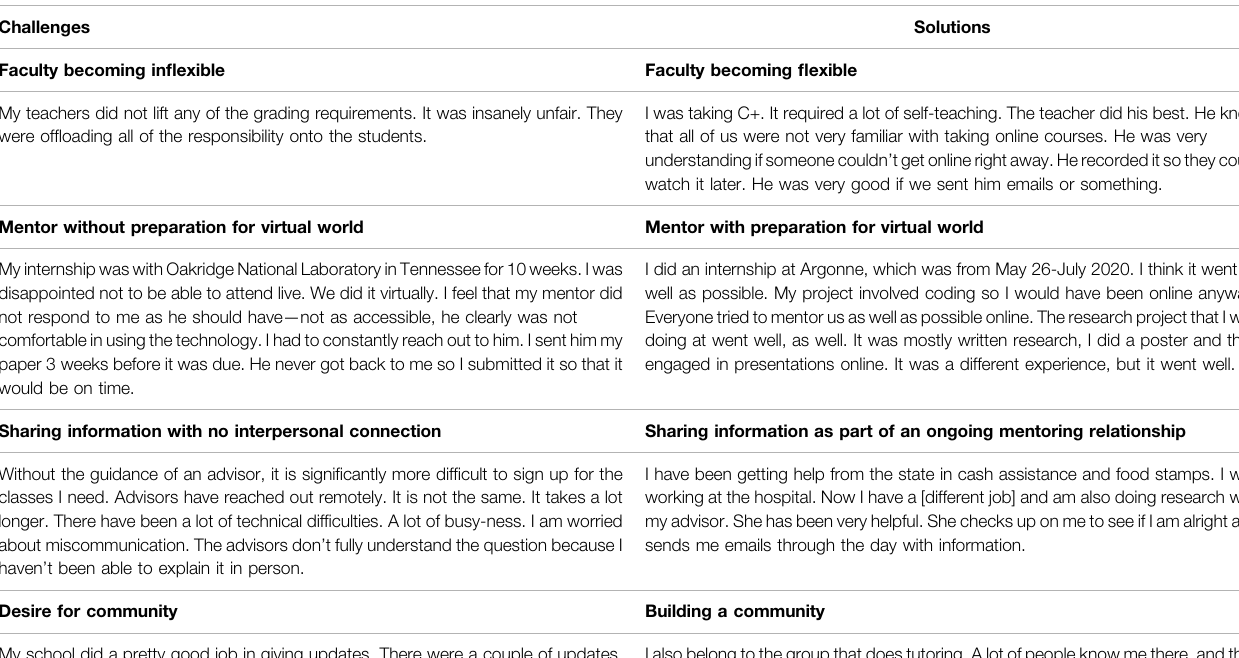
TABLE 3 | Challenges and solutions in communication and